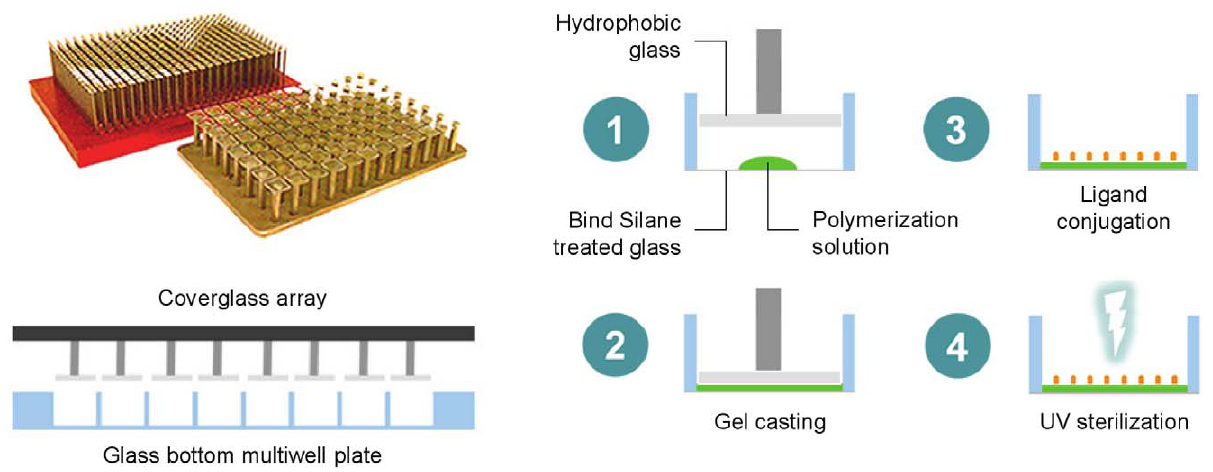
Figure 1. Schematic of polyacrylamide gel incorporation into a multiwell plate. PA gels are cast using an array of coverglass to sandwich polymerization solutions within a multiwell plate, followed by ligand conjugation and sterilization.